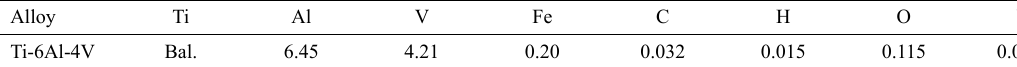
Table 2. The element contents of Ti-6Al-4V titanium alloys used in this study ( mass % ). Alloy Ti